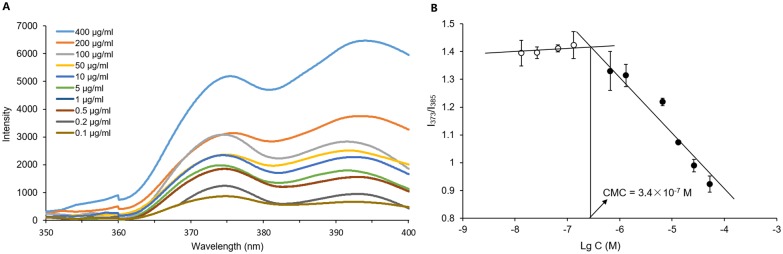
Fluorescence analysis.Fluorescence scanning analysis with pyrene (A) and critical micelle concentration of CSO-g-CM-β-CD@AD-PTX solution (B).